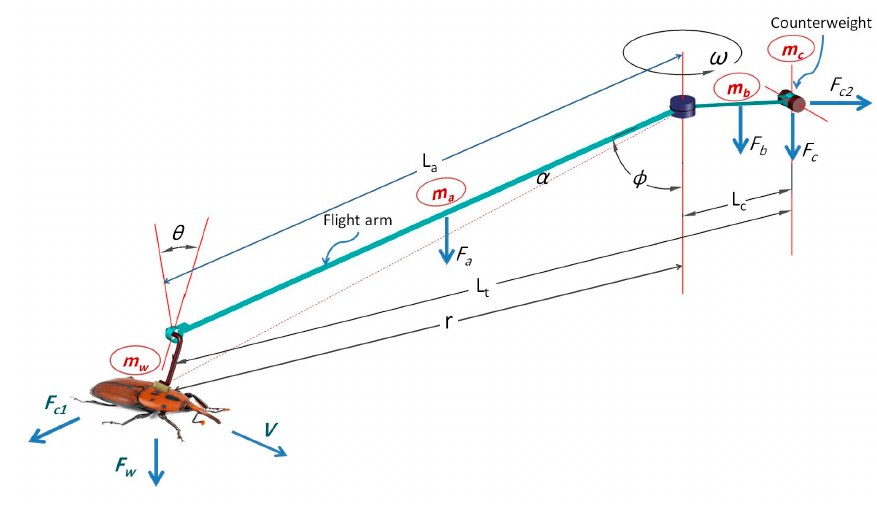
Figure 14. Description of flight kinematics of the red palm weevil ( R. ferrugineus